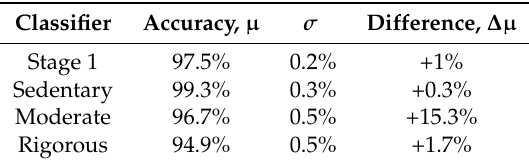
Table 2. Off-Board Classification. The classification accuracy when using both the accelerometer and the